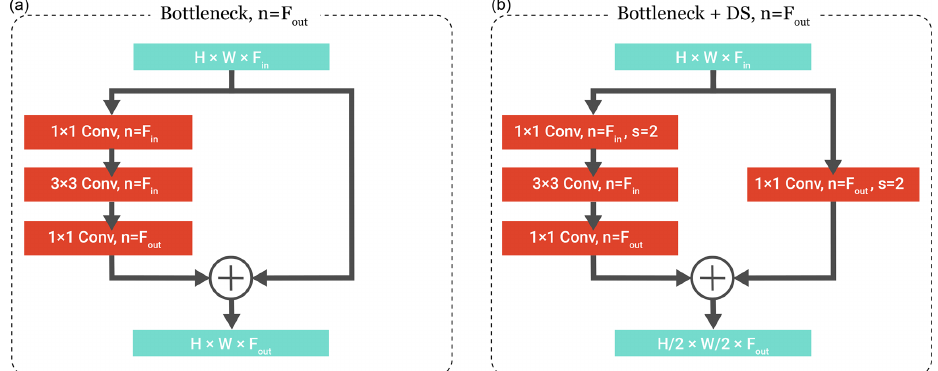
Figure 4. Structure of the bottleneck blocks used in the atmospheric spatial encoder (Fig. 3). The bottleneck block takes a feature map with depth F in as the input and outputs a feature map with depth F out . A regular bottleneck block (a) retains the spatial dimensions of the feature maps, while the downsampling (DS) bottleneck block (b) uses strided convolutions to reduce the spatial dimensions in half. We denote the number of convolutional filters by n and the stride parameter by s